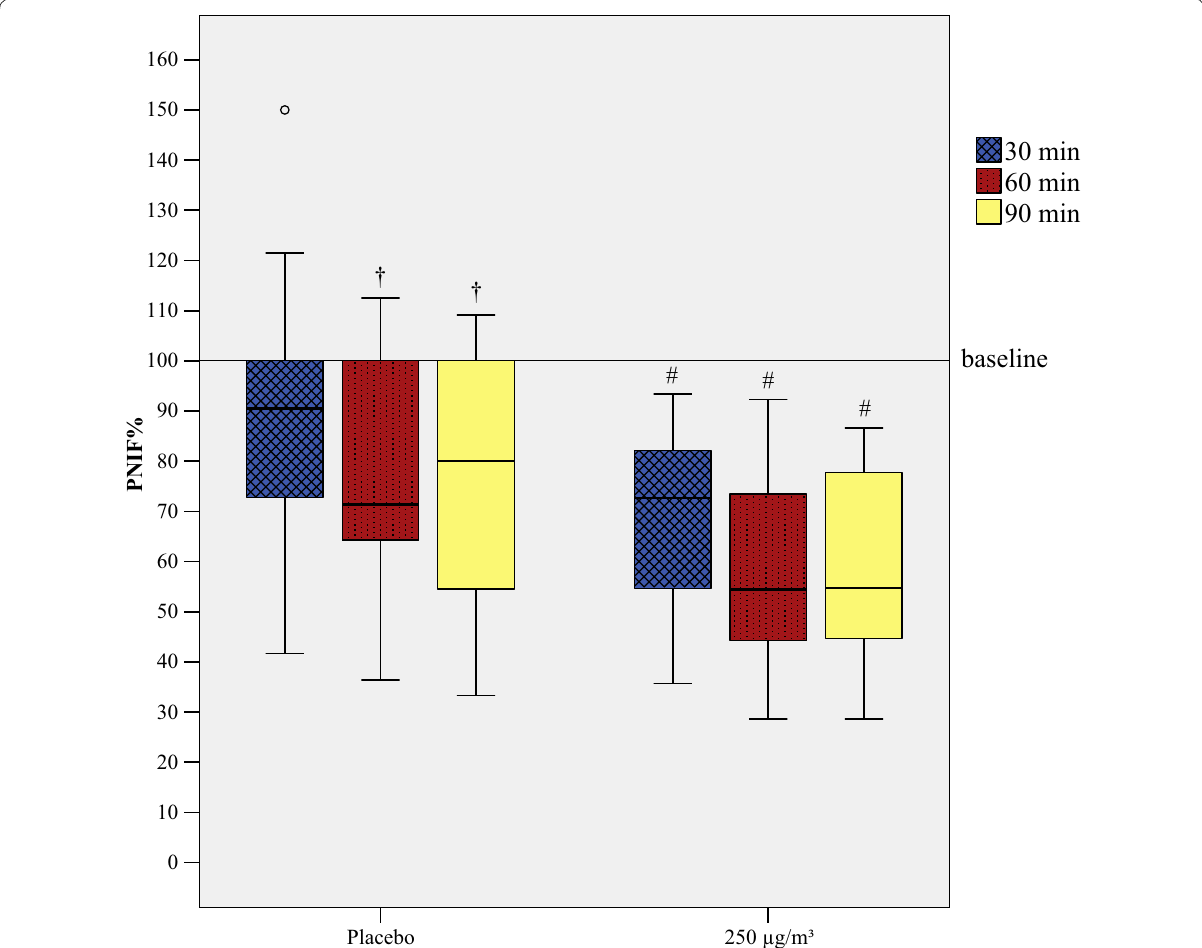
Fig. 3 Reduction of PNIF during exposure with house dust mite (Der p 1) in the GA 2 LEN chamber. PNIF development during exposure with house dust mite material. A hash marks a reduction compared to baseline p < 0.001, a dagger a reduction compared to baseline p < 0.01. Outliers are presented as degree sign. PNIF% from the actively exposed group (250 µg/m 3 ) is significantly lower (p < 0.05) than in the placebo group at